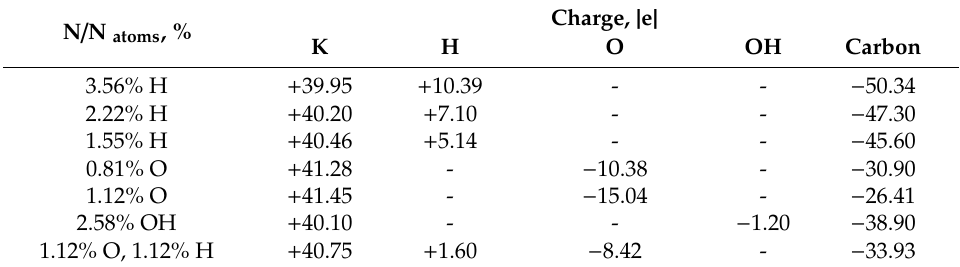
Table 1. Charge distribution at the maximum mass fraction of potassium (4.65%). N / N atoms ,